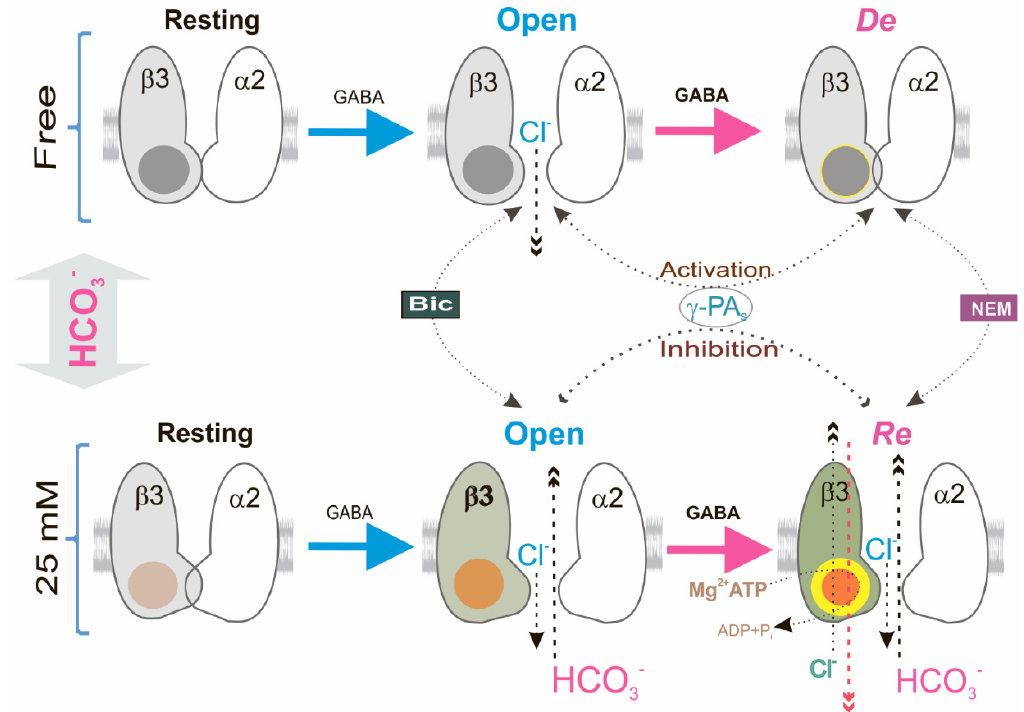
Figure 6. Bicarbonate preferentially stabilized GABA A R via ATPase performance. Model showing four basic conformation states that depict the GABA A R function: a resting state; an open state; a desensitization state; and a resensitization state. In an HCO 3 − -free experimental medium, fist application of GABA shifted the equilibrium from resting state to high-affinity open state, and repeat application of agonist induced GABA A R desensitization. In contrast, in the presence of HCO 3 − (25 mM) in an experimental medium, first application of GABA induced the changes in the conformation of channel and shifted the equilibrium from resting state to high-affinity open state, whereas the reapplication of agonist induced GABA A R resensitization by β 3-coupled ATPase